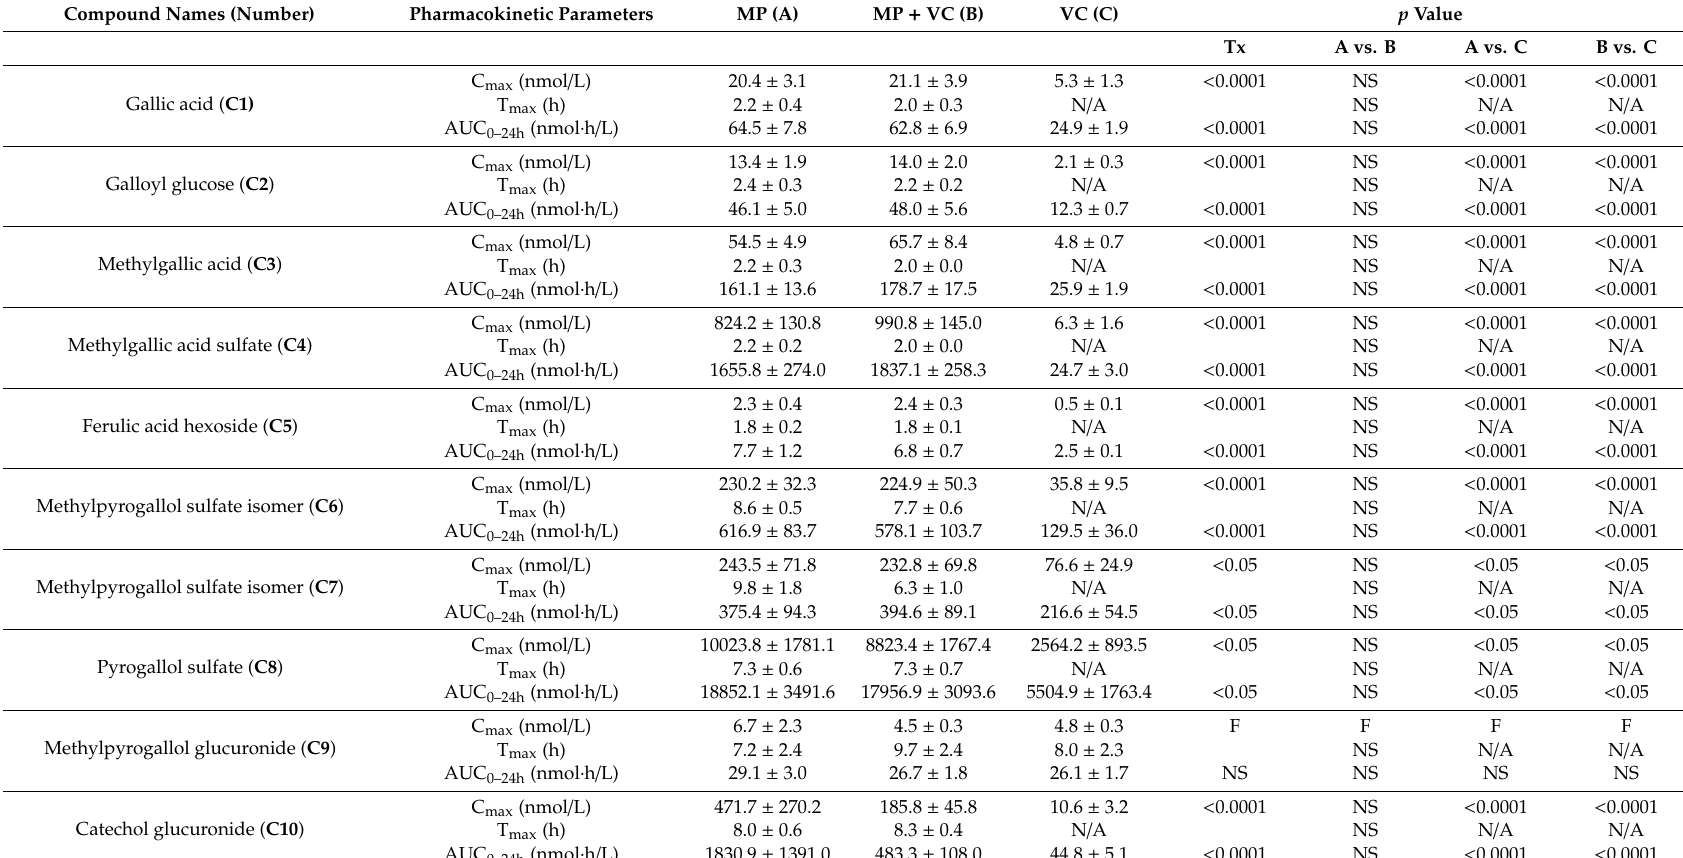
Table 2. Pharmacokinetic parameters (0 − 24 h) and p values of (poly)phenolic compounds and their metabolites in human plasma after ingestion of MP, MP + VC and VC test beverages (mean ± standard